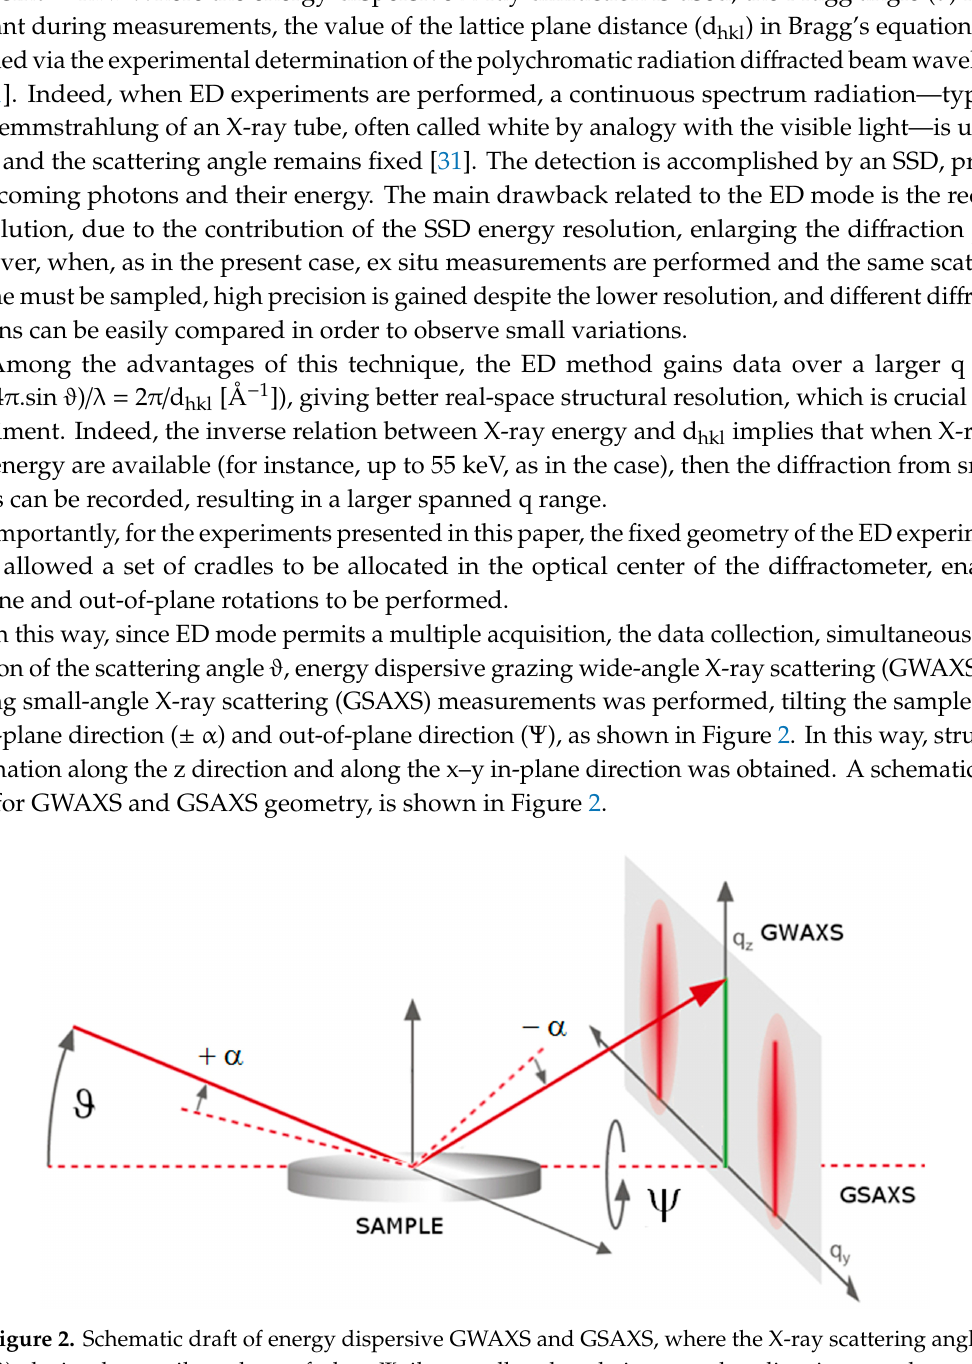
√ √ 3 × 3 Si film grown on